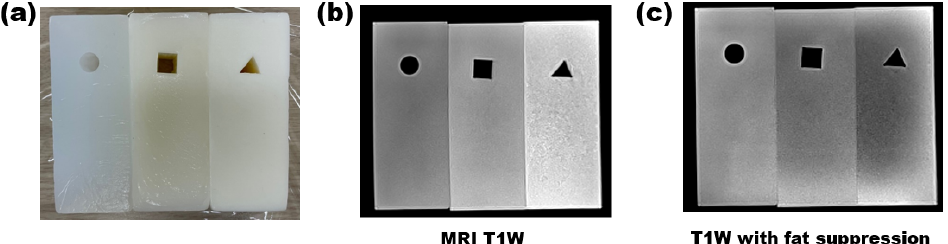
Figure 2. Imaging validation of emulsion gel phantom using MRI. ( a ) Line by line emulsion phantom ( b ) in the T1 weighted image (T1w); the image becomes brighter as fat content increases. ( c ) With fat-suppression, the phantom with higher oil content appears darker.